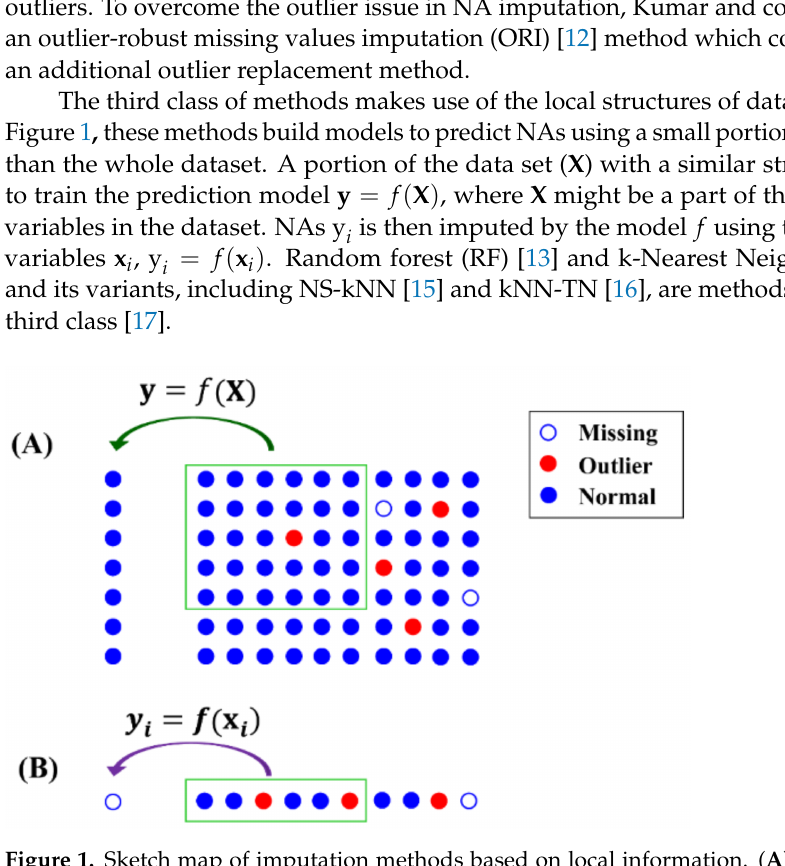
Figure 1. Sketch map of imputation methods based on local information. ( A ) Prediction model f trained using a part of data X . ( B ) NAs predicted using model f